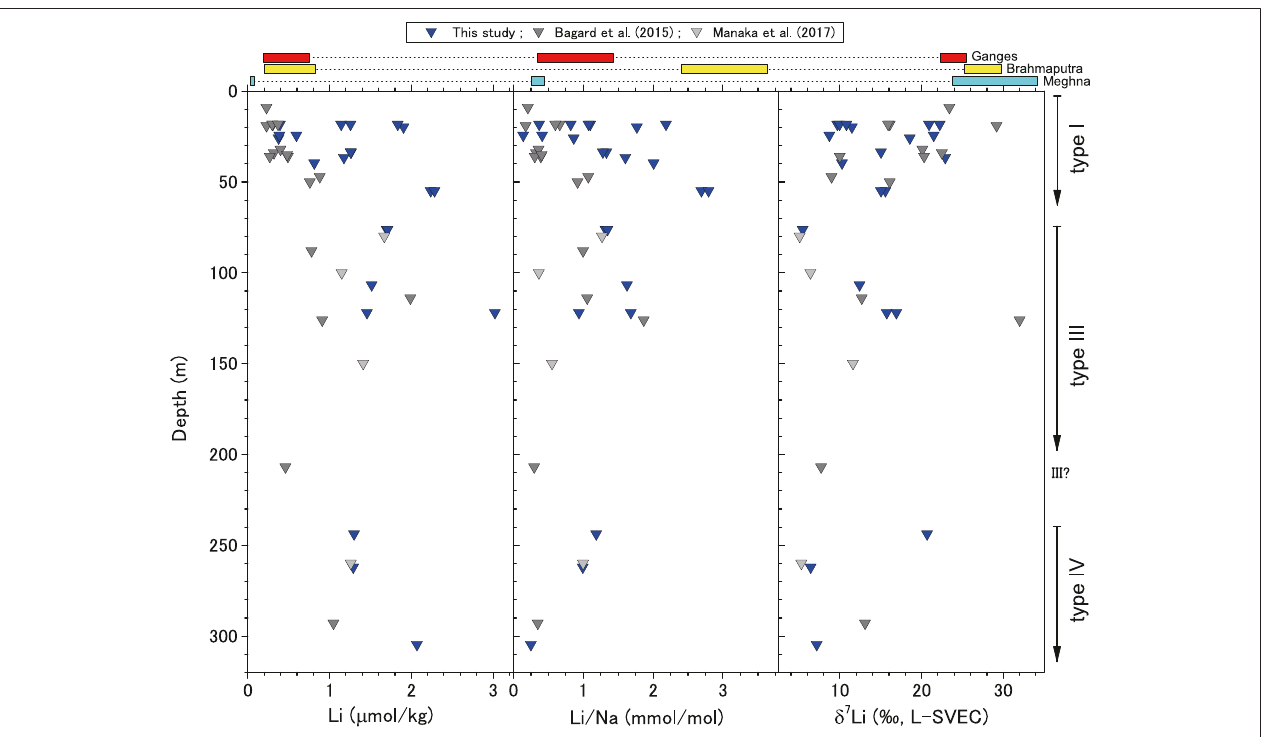
FIGURE 7 | Depth pro fi les of Li concentration, Li/Na ratio ( μ mol kg − 1 /mmol kg − 1 ), and δ 7 Li for groundwater samples. Grey triangles represent data from Bagard etal.(2015)andManakaetal.(2017).Thered,yellow,andlightbluesquaresatthetopshowrangesfortheGanges,Brahmaputra,andMeghnariversintheBengalPlain, respectively. We only compare river data from the Bengal Plain, not from upstream sites, to groundwater.